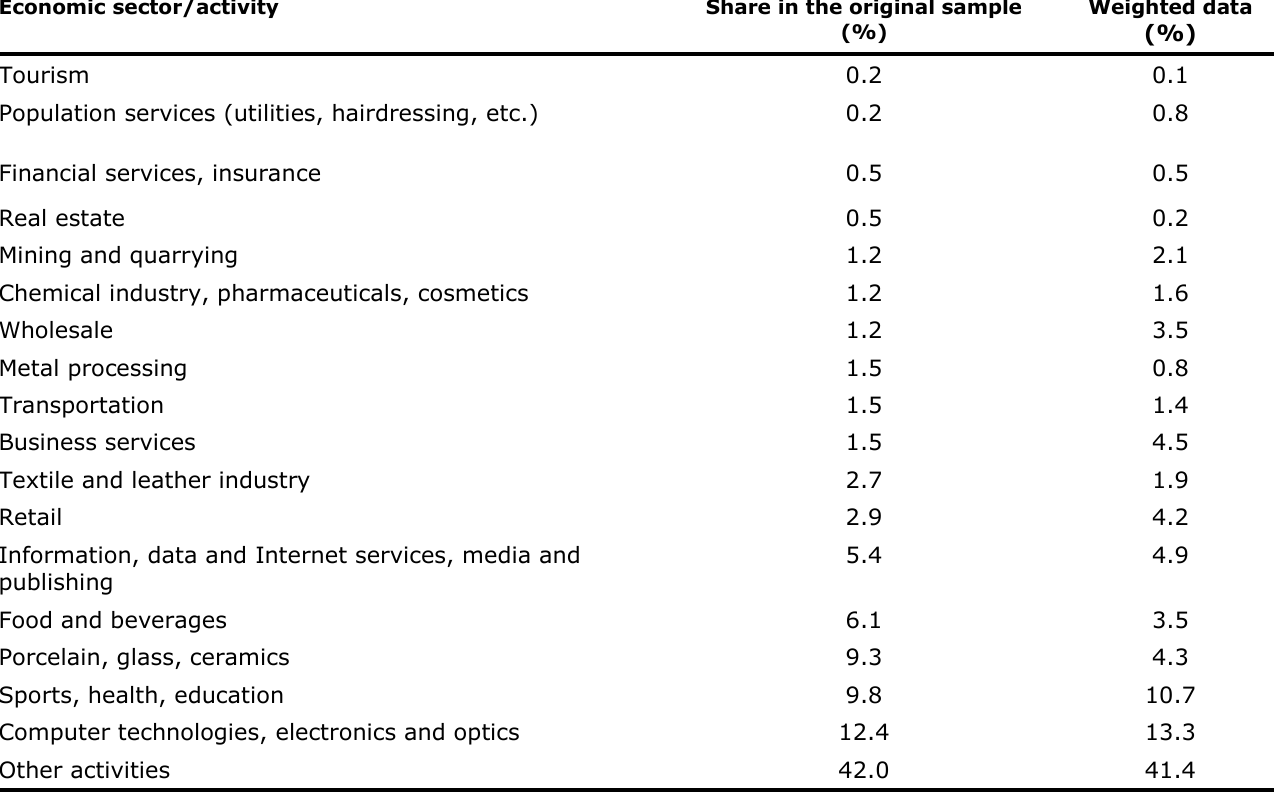
Table 2. Share of respondents by economic